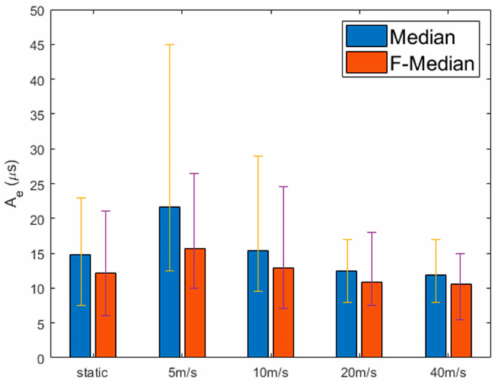
Figure 9. Network error with median and F-median in mobile environment.